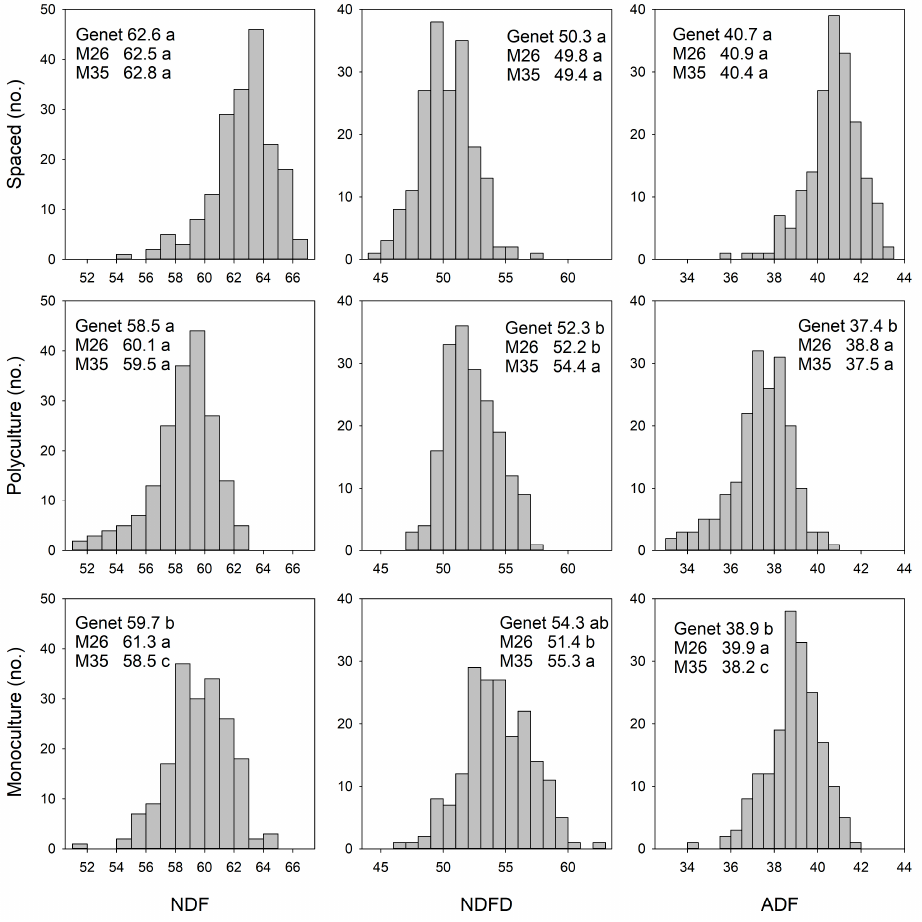
Figure 4. Range and frequency of neutral detergent fiber (NDF), NDF digestibility (NDFD), and acid detergent fiber (ADF) for 192 full-sib progeny (genets) of the M26 × M35 intermediate wheatgrass mapping population evaluated over two years (2016–2017) at Logan, UT, USA in three clonally replicated competition environments (spaced-plants, grass − alfalfa polyculture, and grass monoculture). The genet and parent mean values followed by a different letter (a, b, c) are significantly different than each other at the 0.05 level of probability.